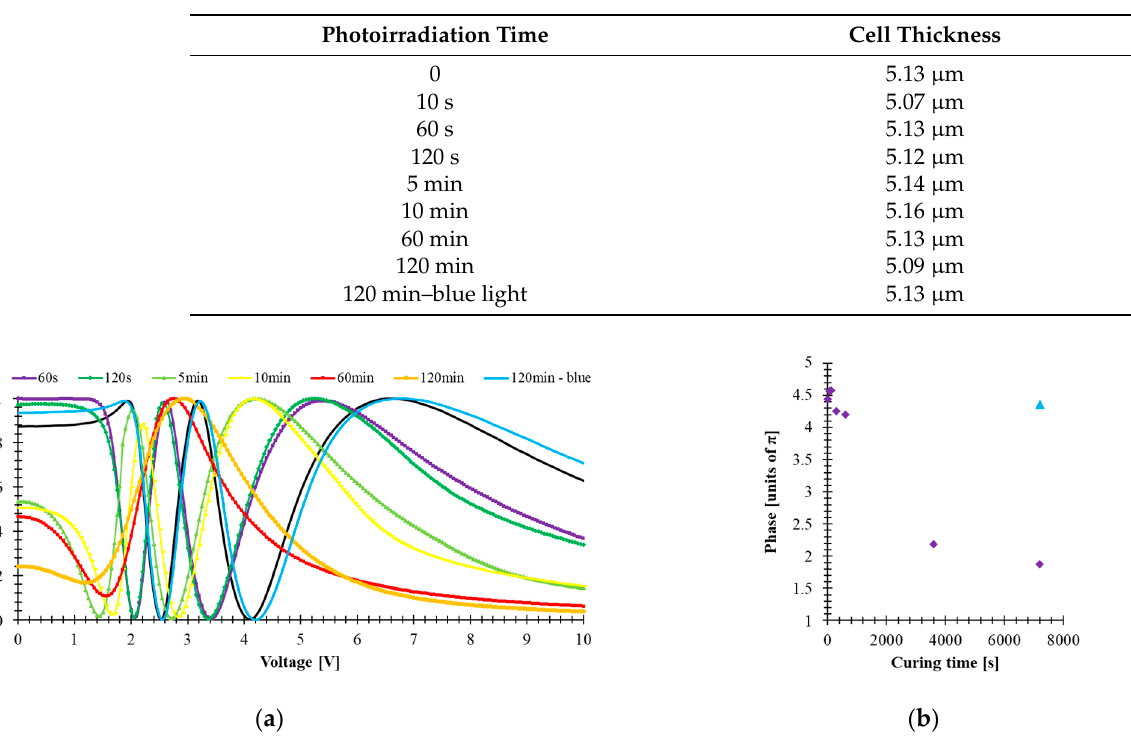
Figure 5. ( a ) Voltage-dependent transmittance and ( b ) phase change of 5005 mixture under UV (time of exposure: 60 s, 120 s, 5 min, 10 min, 60 min, 120 min, power 40 mW/cm 2 , λ = 385 nm) and blue light (time of exposure 120 min, power 40 mW/cm 2 , λ = 445 nm) exposition.